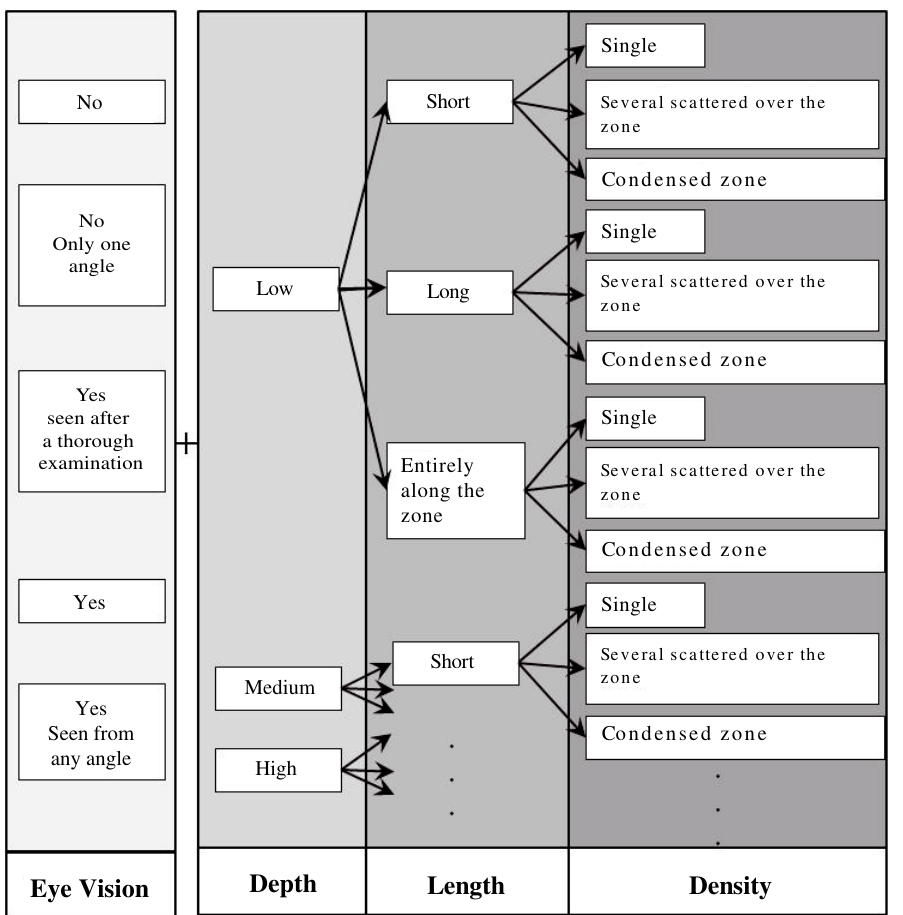
Fig. 1. Tree-like representation of the criteria for a mark-type